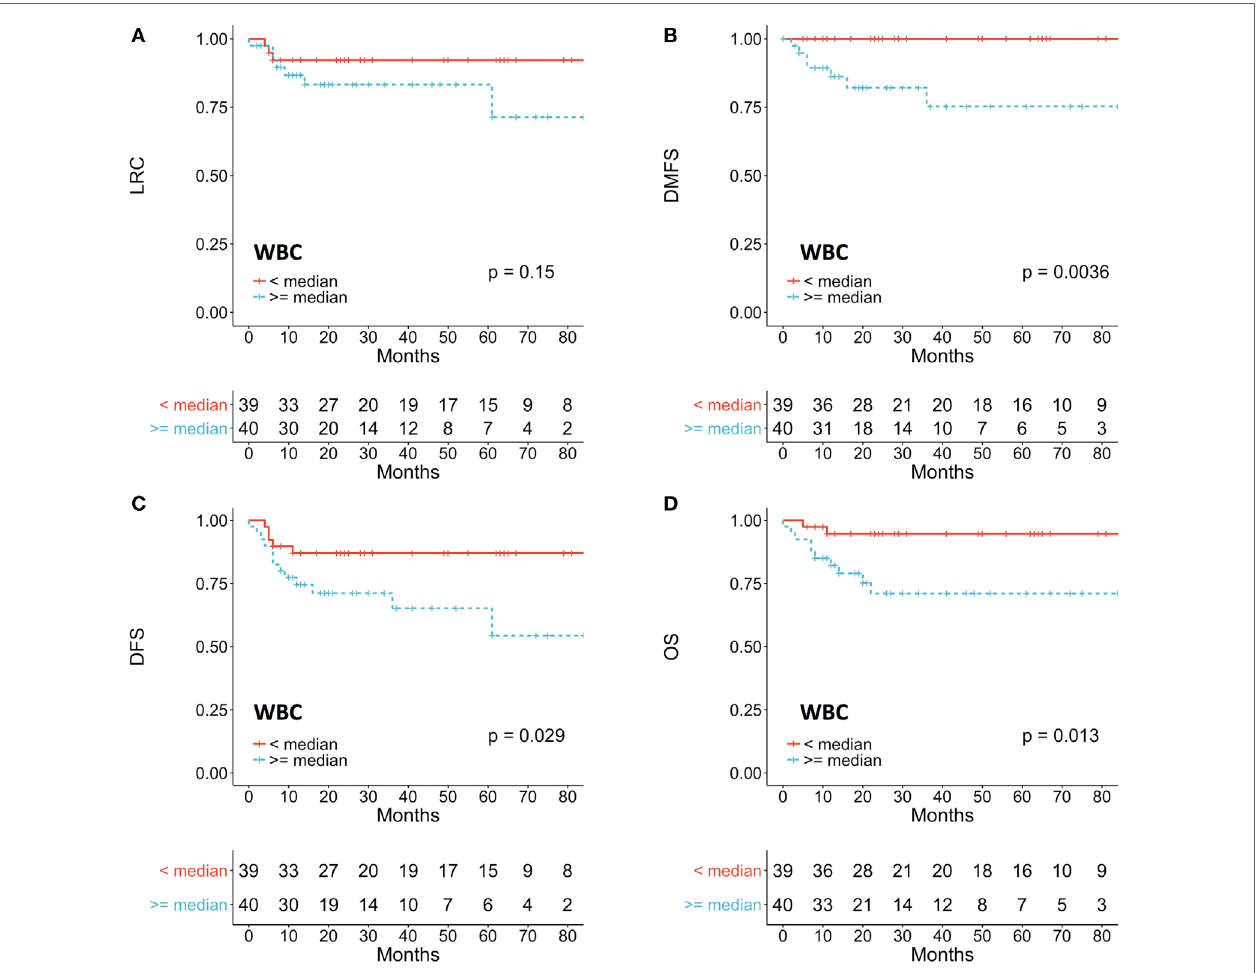
FigUre 3 | Prognostic impact of white blood cell (WBC) count on (a) LRC, (b) DMFS, (c) DFS, (D) OS. Patients were dichotomized according to the median value of WBC count. LRC, locoregional control; DMFS, distant-metastasis-free survival; DFS, disease-free survival; OS, overall